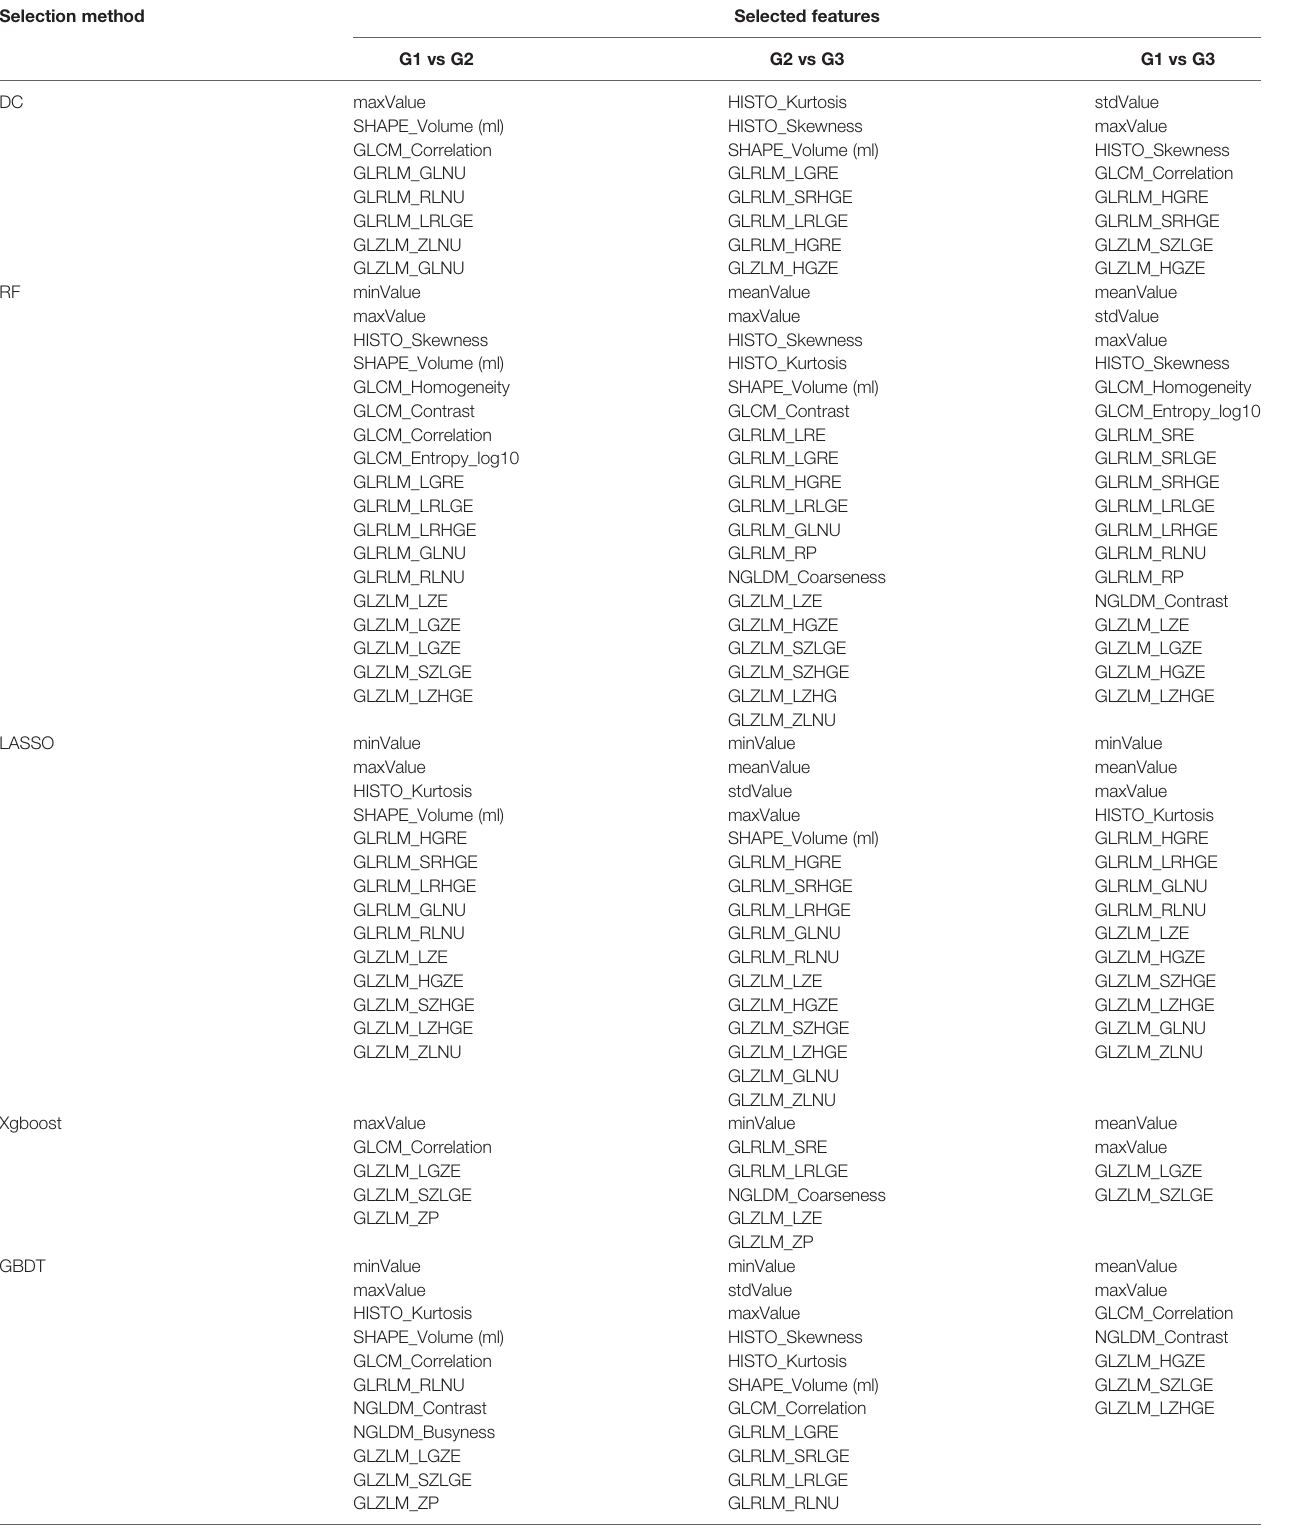
TABLE 2 | Selected features using Distance Correlation (DC), Random Forest (RF), Least Absolute Shrinkage and Selection Operator (LASSO), Extreme Gradient Boosting (Xgboost), and Gradient Boosting Decision Tree (GBDT). Selection